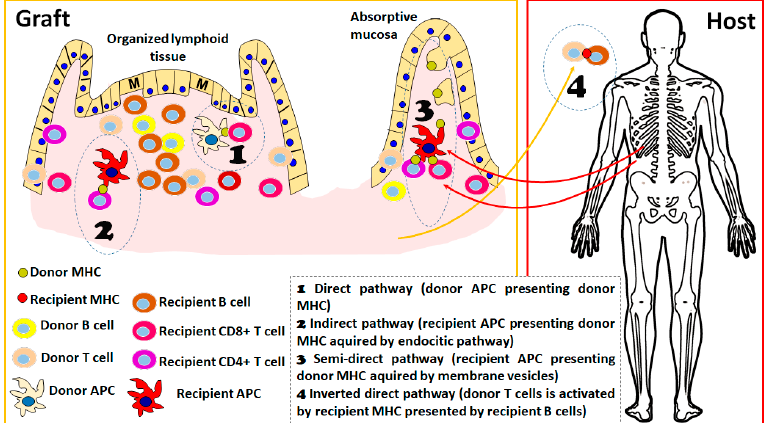
Figure 1. Schematic representation of different alloreactive activation mechanisms considered in the host vs. graft direction. The presence of organized lymphoid tissue in the graft is detailed since it favors the alloresponse; however, processes 1 to 3 could take place in both absorptive mucosa and organized lymphoid tissue. In the early post-transplant period, the 4 pathways are active, whereas in the long term, only processes 2 and 3 are sustained. The figure was produced using Microsoft PowerPoint TM .